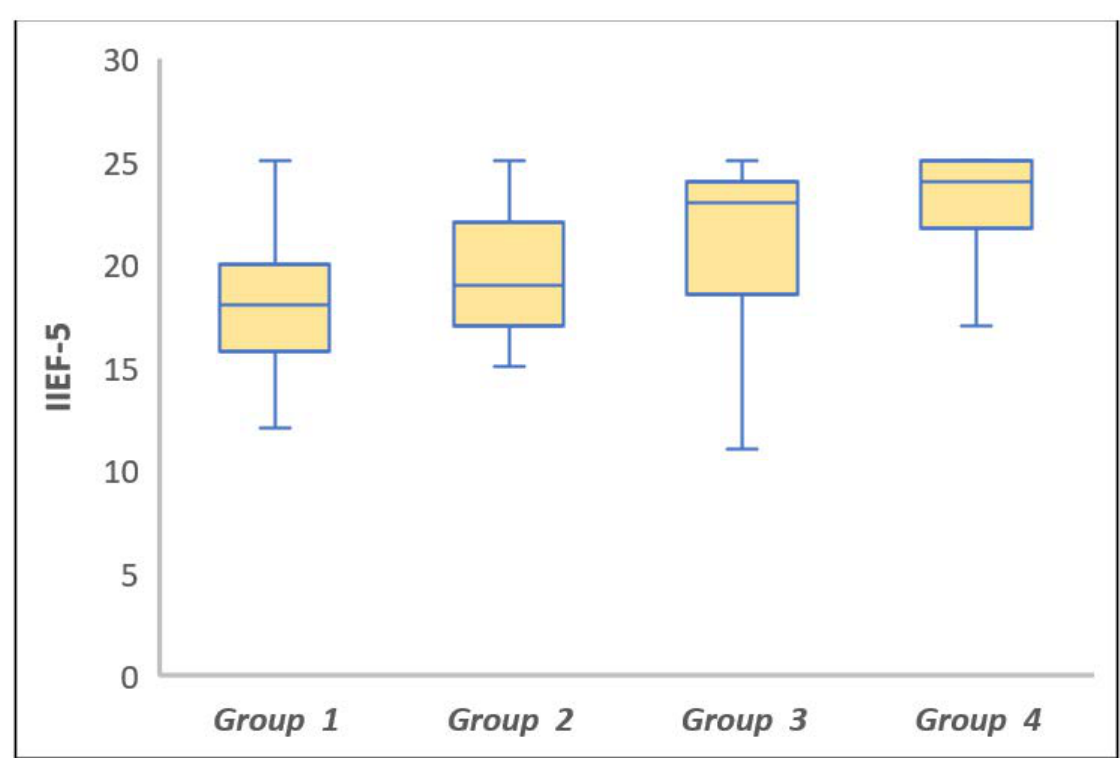
Figure 1. Comparison of the IIEF-5 scores between the study groups. The horizontal lines in the middle of each box show the median values, while the top and bottom borders of the box mark the 25th and 75th percentiles, respectively. The whiskers above and below each box indicate the maximum and minimum IIEF-5